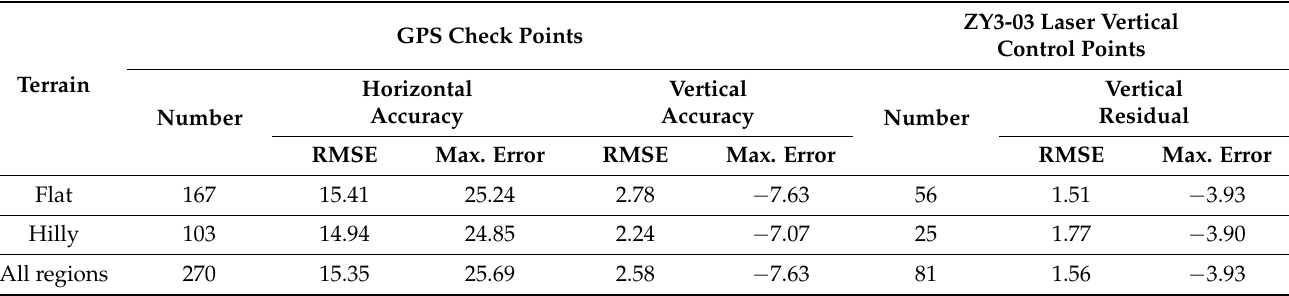
Table 10. Experimental results of integrated processing of ZY3 experimental data (first group).